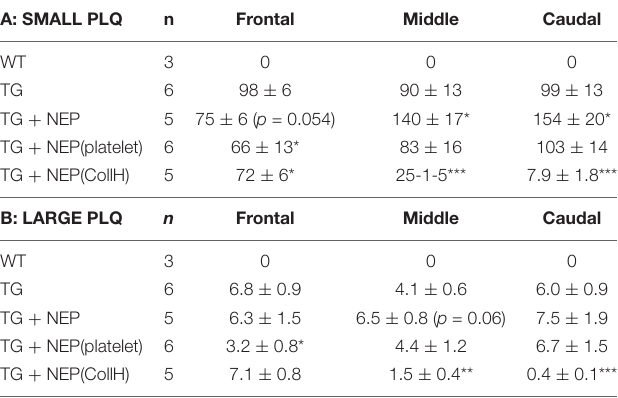
TABLE 3 | Intranasal infusion of neprilysin and quantification of